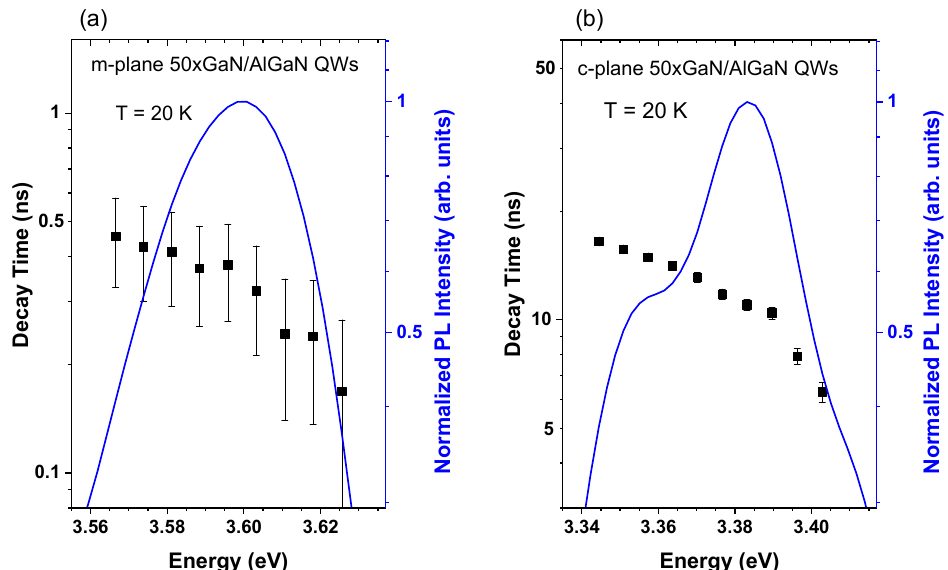
Figure 8. Low-temperature PL decay times determined for different spectral positions for the non-polar ( a ) and polar ( b ) GaN/AlGaN MQWs. The normalized low-temperature time-integrated PL spectra are shown as blue solid lines. The relative changes in the decay times are the same for a better comparison.